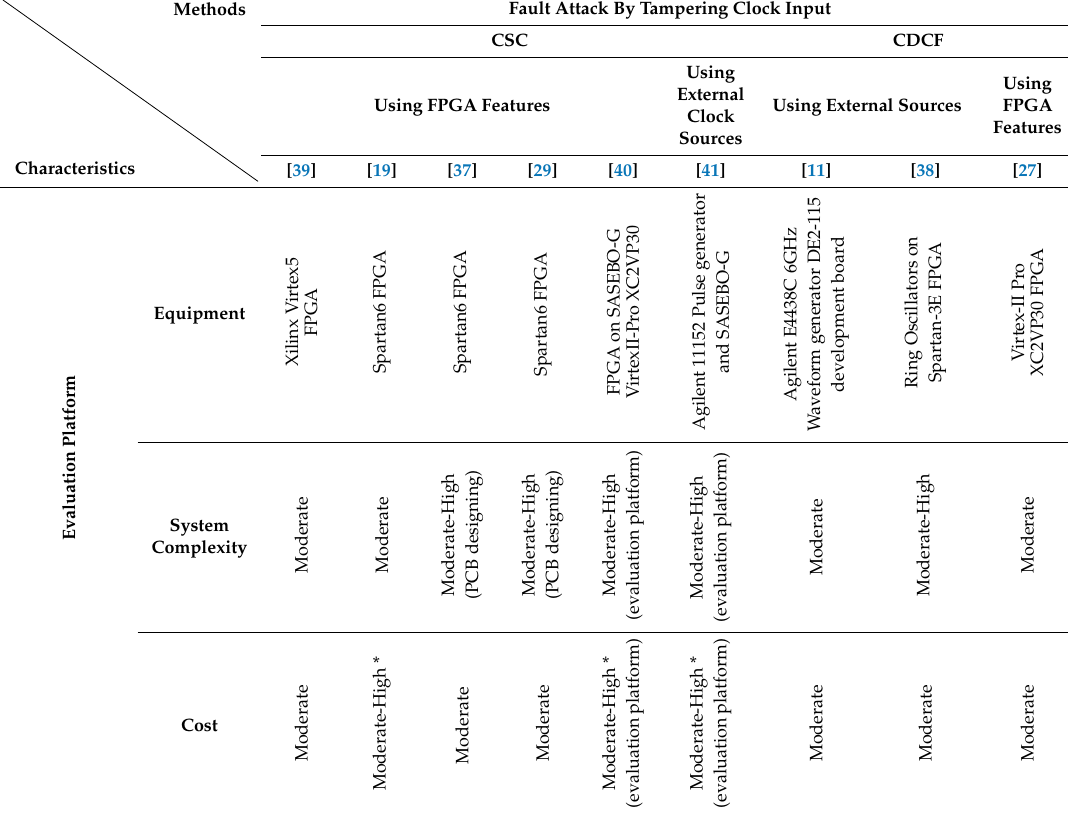
Table 3. Review of previously proposed clock glitch